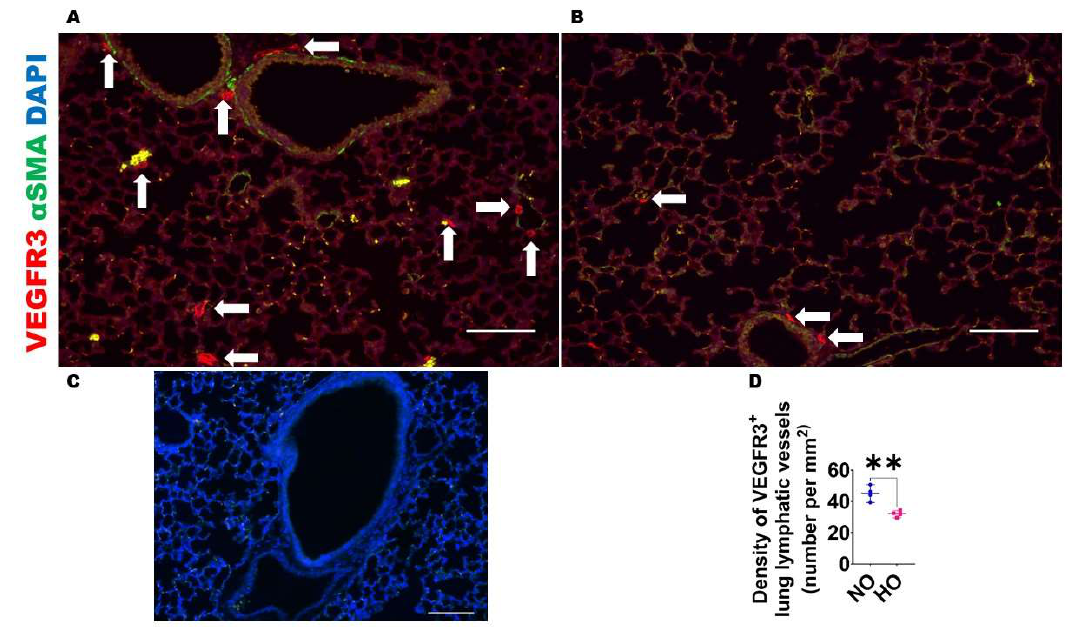
Figure 5. Lung VEGFR3 + lymphatic density in neonatal mice exposed to HO. The lung lymphatic density was determined by quantifying VEGFR3 + lung vessels (arrows) on P14 in WT mice exposed to 21% O 2 (NO) or 70% O 2 (HO) from P1 to P14. A-B. Representative VEGFR3 + (red), αSMA (green), and DAPI (blue) immunofluorescence-stained lung sections from mice exposed to NO ( A ) and HO ( B ) for 14 d. ( C ). Representative lung section from NO exposed animals stained with secondary antibodies only (negative control). Scale bar = 100 µm. ( D ). Quantification of VEGFR3 + lung vessels. Values are presented as the median with the range ( n = 4/group). Significant differences between exposures are indicated by **, p < 0.01 ( t -test).